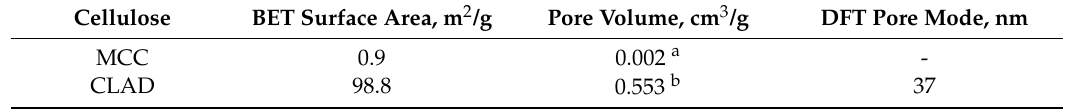
Figure 1. Scanning electron microscopy (SEM) image of ( A ) microcrystalline cellulose (MCC) and ( B ) Table 2. Specific surface area and pore volume of studied celluloses. Cladophora cellulose (CLAD). Magnification 20,000×. Table 2. Specific surface area and pore volume of studied celluloses.